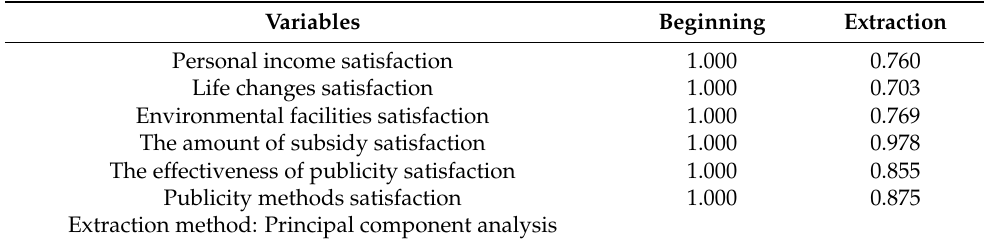
Table 4. Satisfaction common factor variance of the CCLBP.